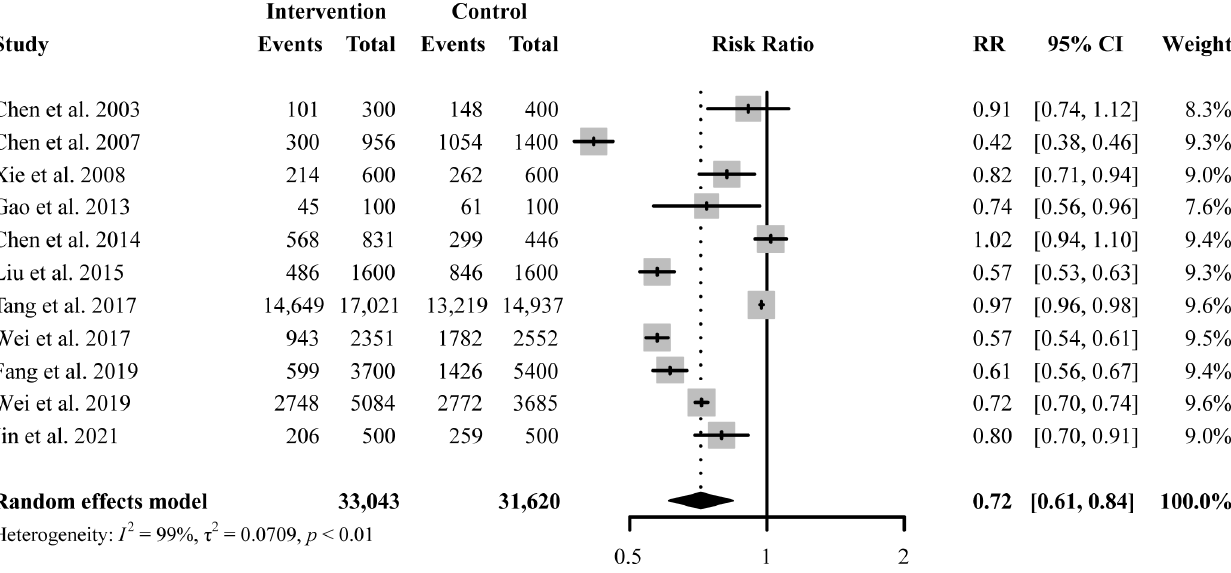
Figure 3. Effect of education-only intervention or plus other interventions on antibiotic prescription rate. Abbreviations: RR, risk ratio; CI, confidence interval [23,24,26,27,29–31,33–36].